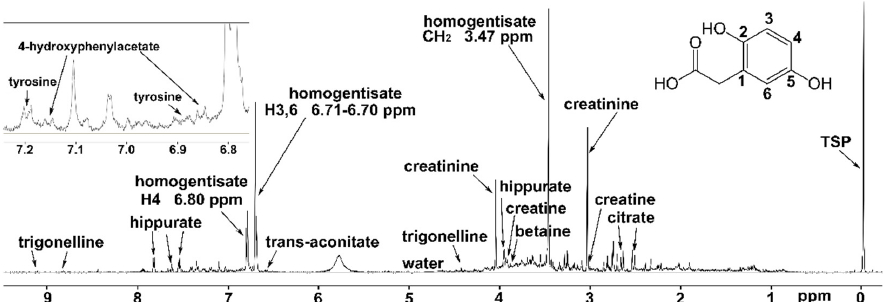
Figure 2. Proton 1D spectrum of a urine sample from the AKU non-treated patient with the lowest HGA concentration (AKU.356, 2.7 mM); even at the lowest concentration, HGA signals dominate the spectrum both upfield (CH 2 singlet at 3.47 ppm) and downfield (aromatic system from hydrogens 3,6 and 4 at 6.70, 6.71 and 6.80 ppm); at the same time, low concentration metabolites (e.g., tyrosine and 4-hydroxyphenilacetate, see inset) are detected and quantified. Signals of other relevant metabolites among the sixty identified are labeled. AKU samples show the metabolite in the tens of millimolar range (Table 1), orders above all the other molecules (except for creatinine). In contrast, controls show no detectable peaks to the limit of detection (LoD, see Materials and Methods). Table 1. The concentration of homogentisate in the urine of AKU patients. Patient Code C HGA (mM) Patient